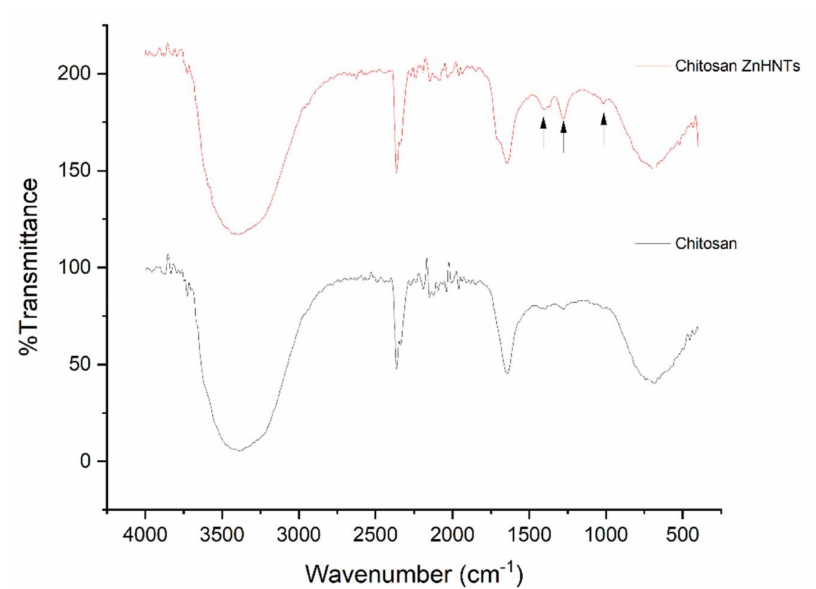
Figure 5. FTIR spectra of the coatings. Arrow depicts the new peaks observed upon the addition of ZnHNTs-GS at 1028 (in-plane Si–O stretching of HNTs), 1278 and 1401 cm − 1 corresponding to the C–N stretching of gentamicin.